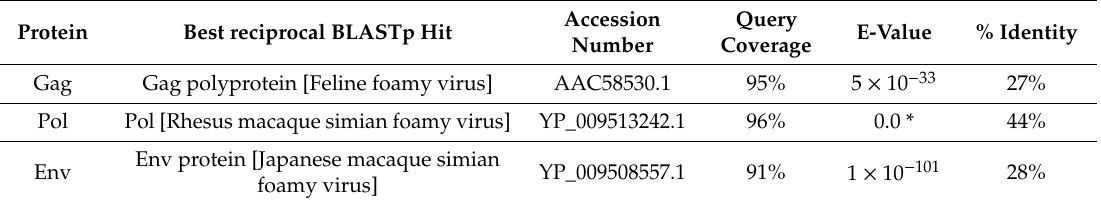
Table 1. Reciprocal BLASTp analyses of ERV-Spuma-Spu against the National Center for Biotechnology Information (NCBI) non-redundant retroviral protein